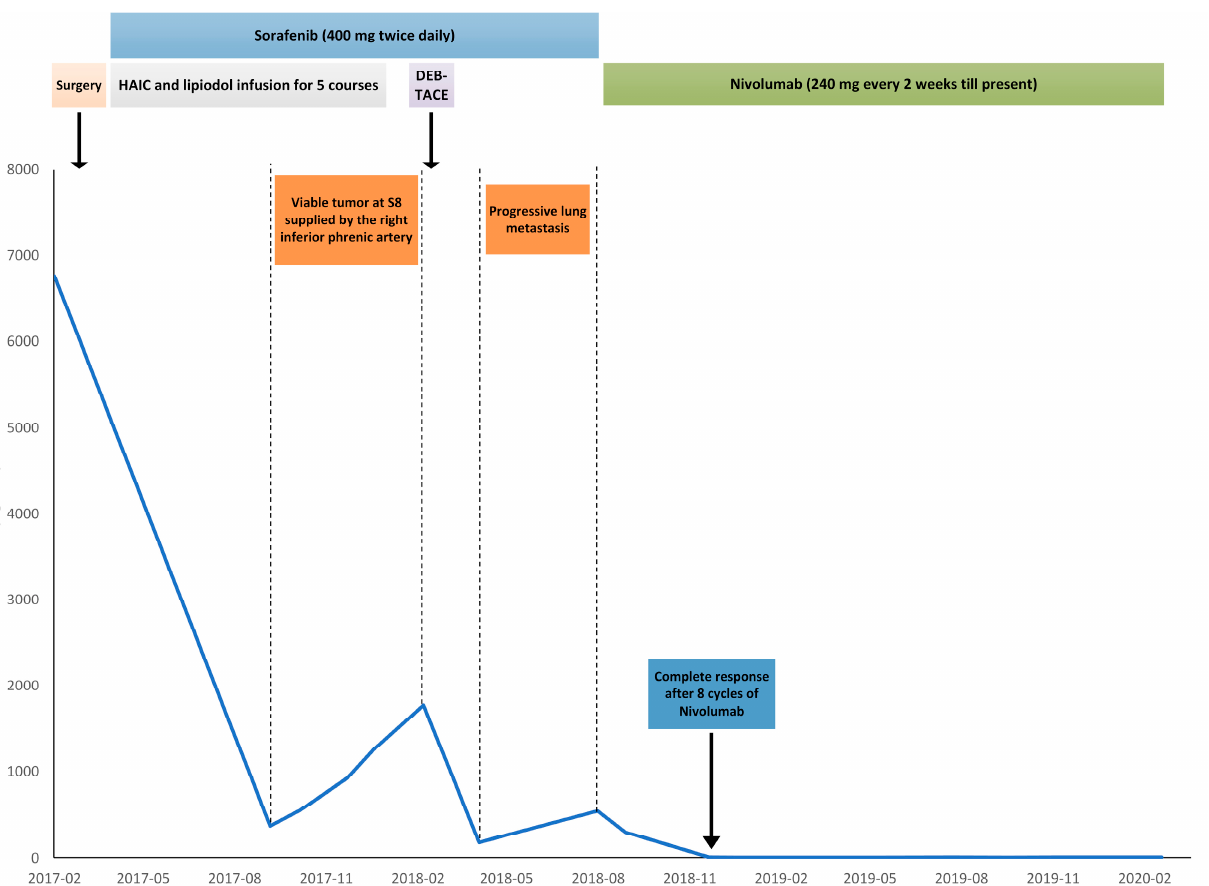
Figure 2. A graph demonstrating the corresponding changes in serum alpha-fetoprotein (AFP) level upon different treatment modalities prescribed throughout the clinical course.